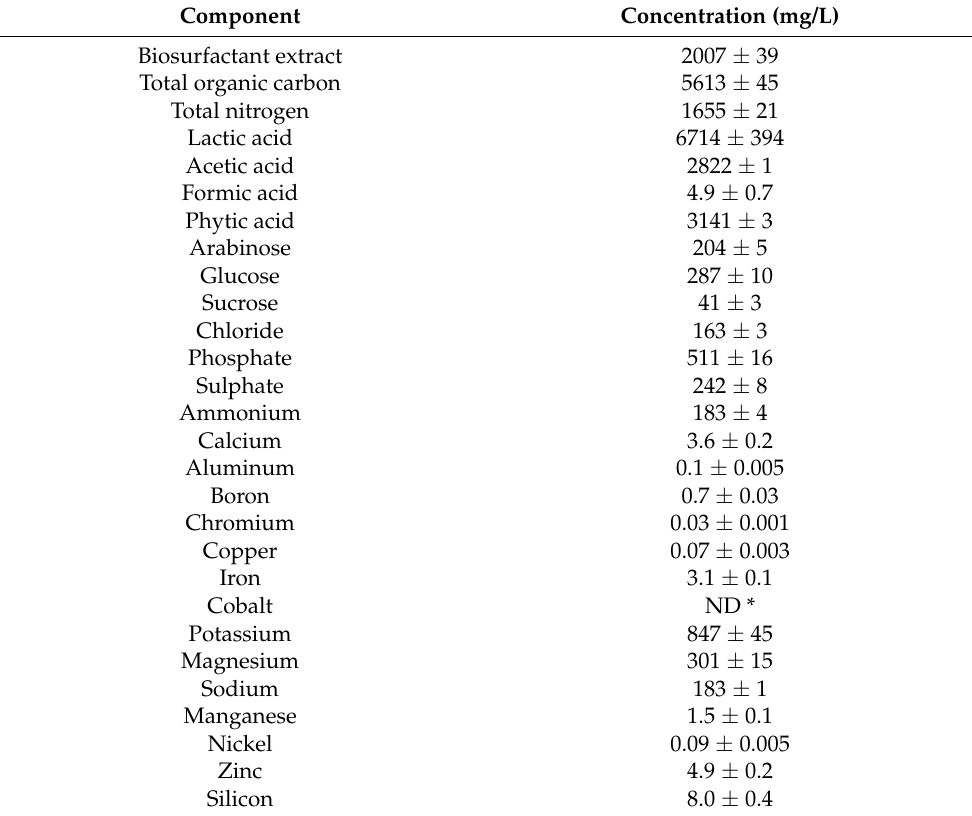
Table 1. Chemical composition of diluted (20 times) raw corn steep water used in this study after solid